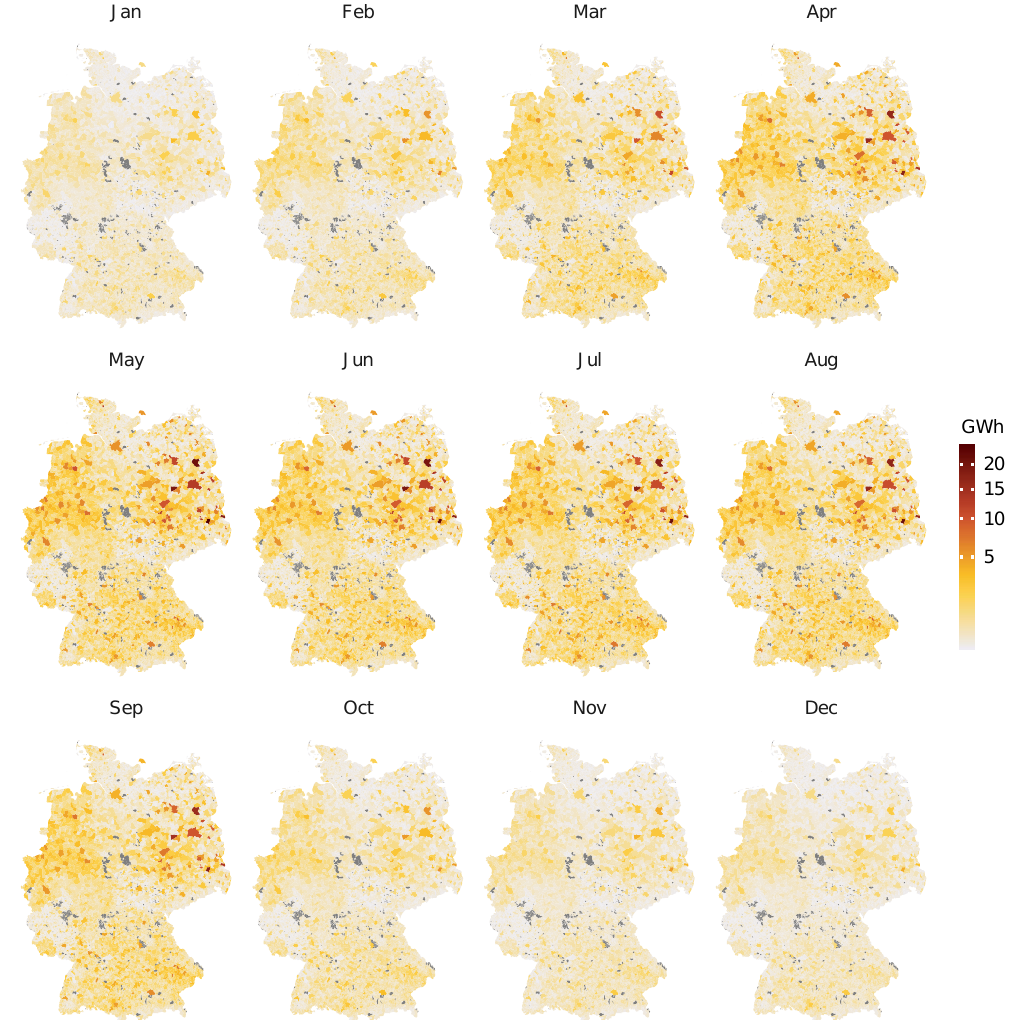
Figure 5. Aggregated monthly power generation from PV systems at LAU2 level in Germany for 2016. In the dark grey areas no PV systems are installed.